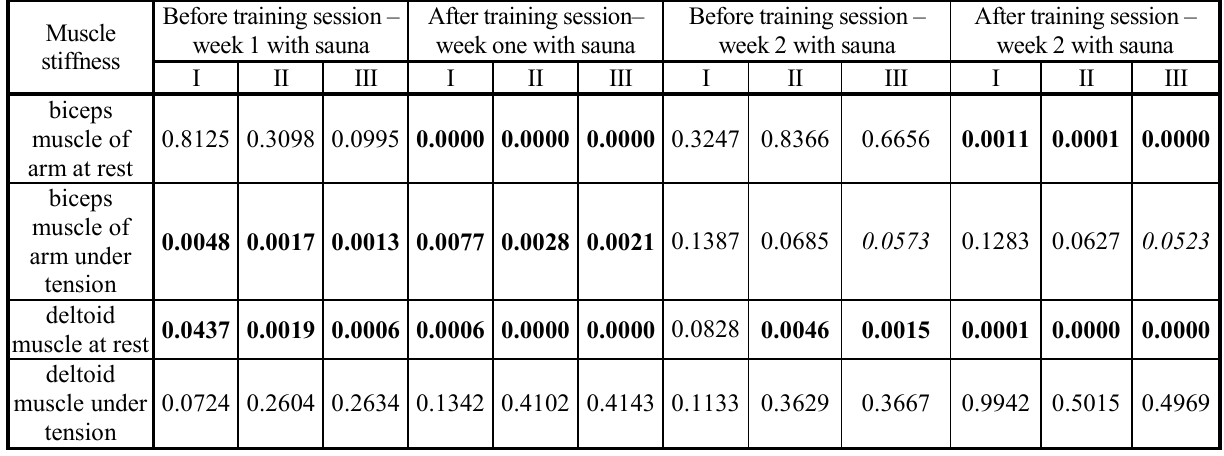
Stiffness parameters for Kalisz-based swimmers in the training cycle with athletic recovery